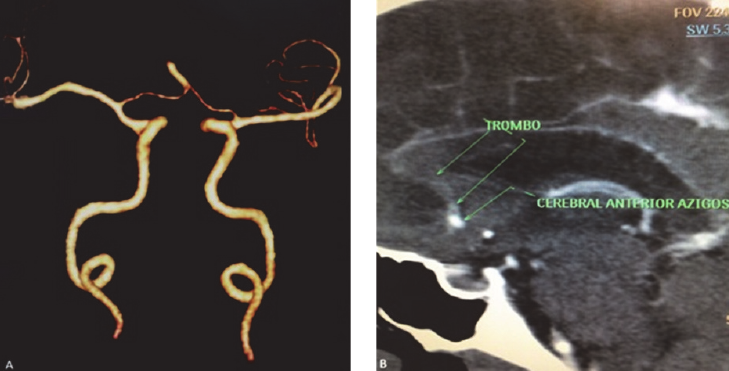
Figure 2: 3D reconstruction of cerebral angiotomography (A) and sagittal reformatting (B) showed azygos anterior cerebral artery with endoluminal thrombus, about 1cm of its common origin, reducing the vascular flow